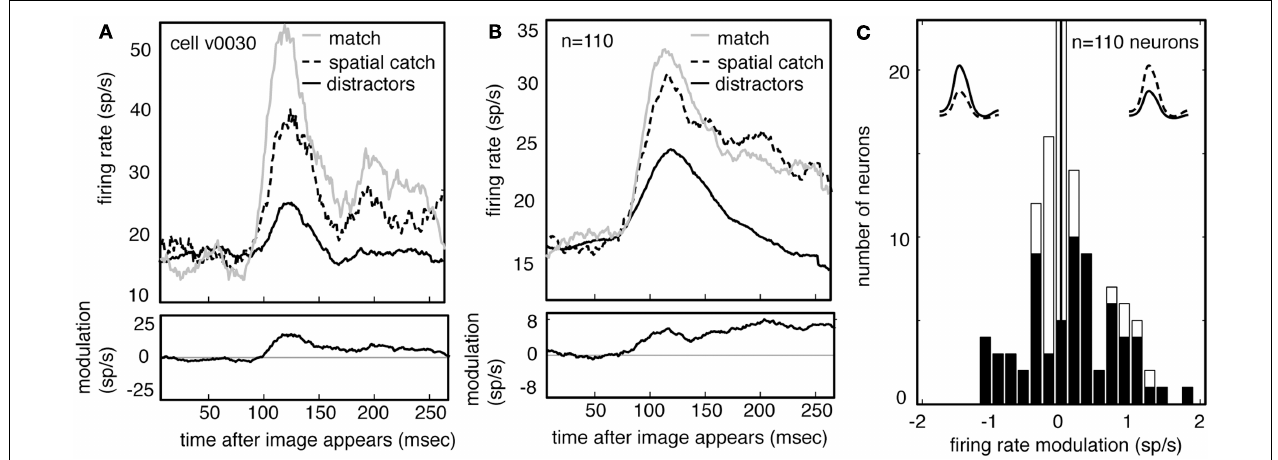
conditions, and their difference. Across the population, responses to the catch are greater than responses to the distractors.The size of this modulation is relatively consistent across the response. Response to match is shown for comparison (gray). (C) Histogram of the size of catch enhancement for all the neurons in our sample. Black bars denote significantly modulated neurons. Population is significantly skewed to the right ( p < 0.01), indicating that match enhancement is significantly more common than